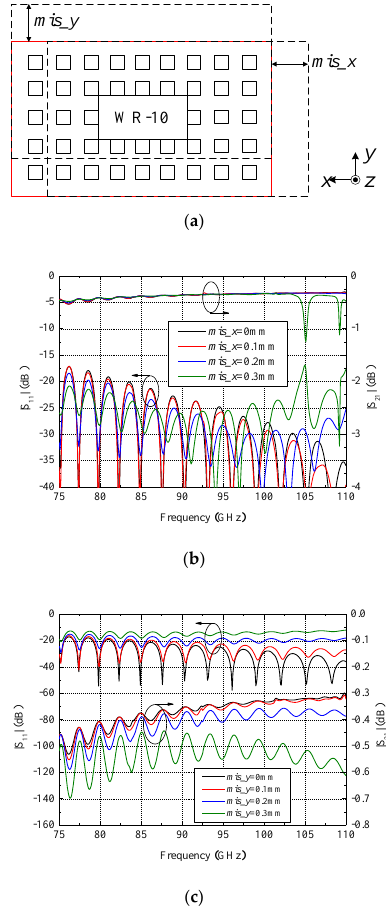
Figure 11. Tolerance analysis of the misalignment in the x_ or y _ direction. ( a ) Schematic diagram of the transition part in the xy plane; ( b ) simulation results given by different misalignments in the x _ direction; ( c ) simulation results given by different misalignments in the y _ direction.